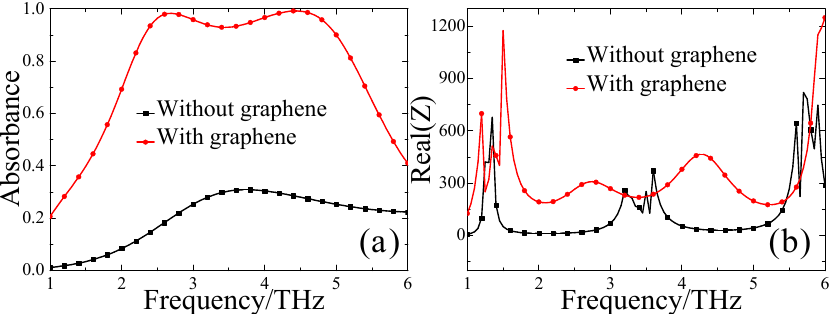
Figure 2. ( a ) The simulated absorbance of the designed MMA with and without graphene, and ( b ) the corresponding real part of the wave impedance.